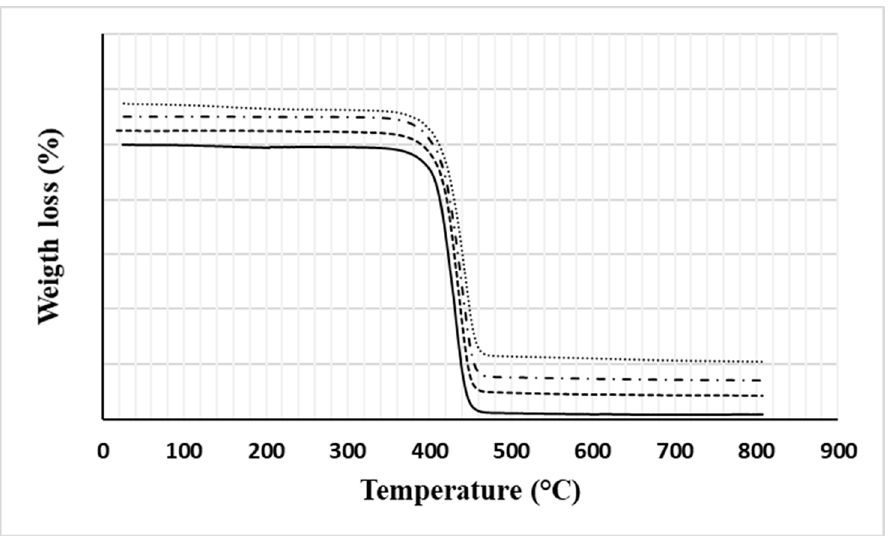
Figure 2. TG curves of all investigated materials (solid line: PA6, dashed line: PA6 + 1% GNP, dashed and dotted line: PA6 + 3% GNP, dotted line: PA6 + 5% GNP).